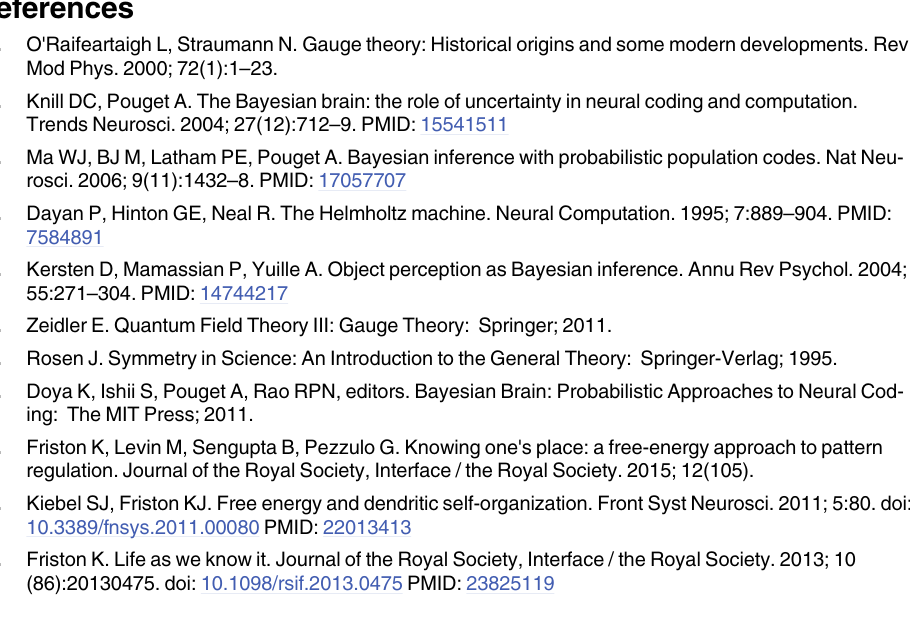
S1 Fig. Conjugate gradient-descent algorithm on manifolds. (A) New parameters ( θ ) are selected by performing gradient descent on orthogonal subspaces with gradient G and the descent direction H . (B) On a Riemannian manifold, minimization along lines (as in a Euclid- ean subspace described in A) is replaced by minimization along geodesics. This creates a prob- lem, in that H i and H i − 1 are in two different tangent spaces and thus cannot be added together. (C) Vector addition as in Eqn. 12 (in S3.2) is undefined on a Riemannian manifold. Addition is replaced by exponential mapping followed with parallel transport described using a covariant gauge field (Levi-Civita connection; see text). (TIFF) S2 Fig. Parallel transport on Riemannian manifolds. (A) The Riemann exponential map is used to map a vector field H from T M ! M whilst a logarithmic map is used to map the vec- tor fi eld from M ! T M . (B) Graphical illustration of parallel transporting a vector fi eld H using a Schild ’ s ladder (see text for